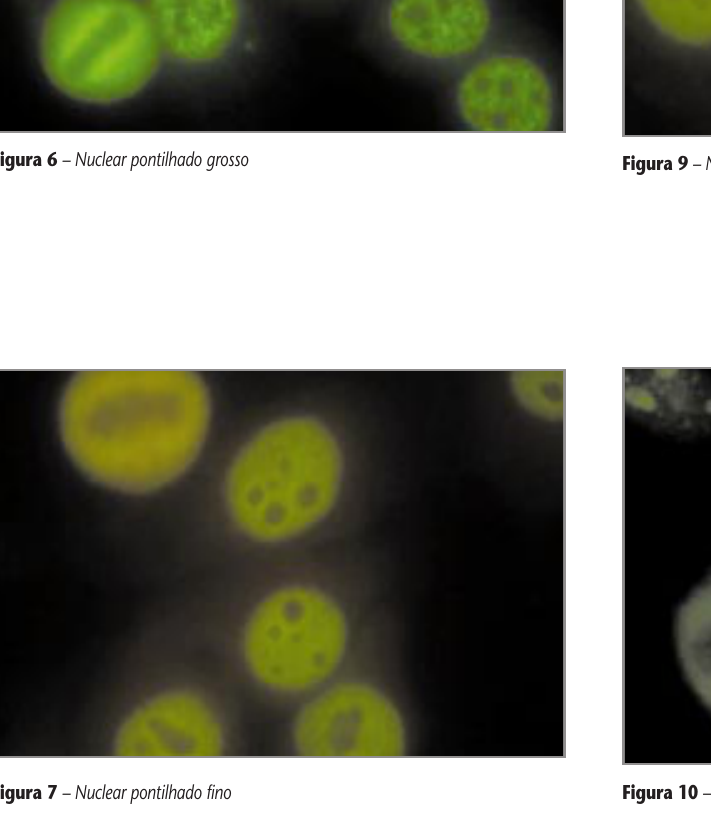
Figura 10 – Nucleolar homogêneo